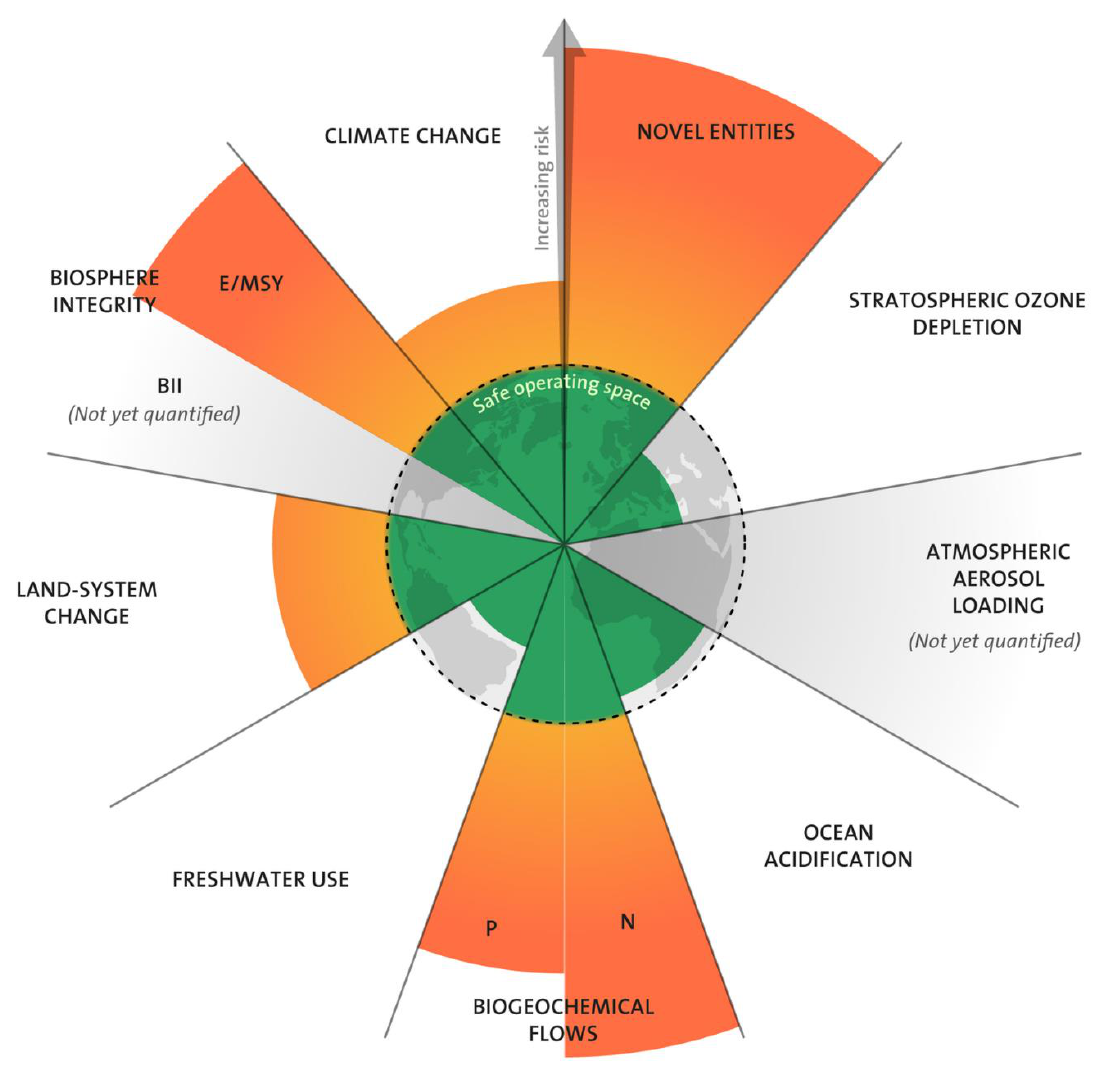
Figure 1. Planetary Boundaries: processes which can disturb the stability of the Earth; green zone: safe operating space; red zone: planetary boundaries are exceeded. Designed by Azote for the Stockholm Resilience Centre, based on an analysis in Persson et al. 2022 [13] and Steffen et al. 2015 [12], BII: functional diversity (Biodiversity Intactness Index), E/MSY: genetic diversity (extinctions per million species-years).